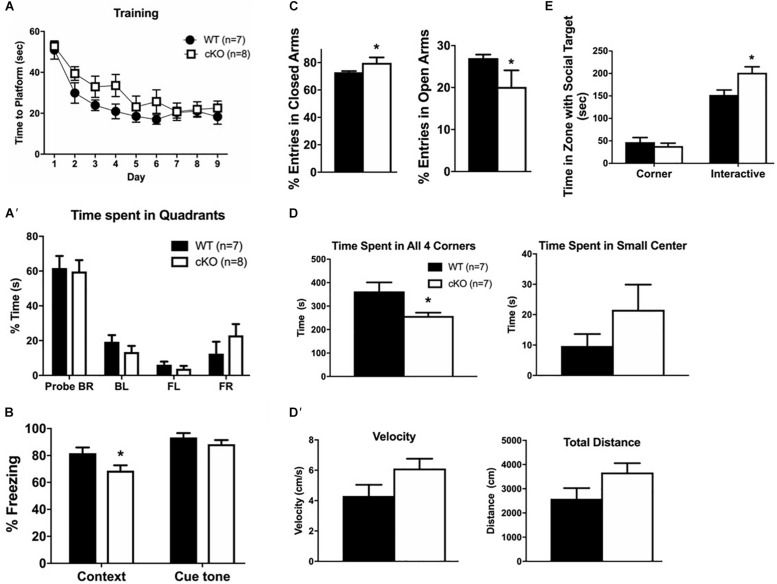
Cortical projection neuron dysgenesis alters cognitive function. (A) Morris water maze training sessions. The time it took the mice to reach the platform was recorded. No statistically significant differences were detected between genotypes during 9 days of training. (A’) Trial day 10 in the Morris water maze reveals no differences in the percentage of time spent in the different quadrants. Both WT and mutant mice spent most time in the BR quadrant that contained the platform. (B) The fear-conditioning assay reveals that mutant mice responded normally to the cue tone after training but have a reduced context-dependent response relative to controls. (C) The elevated plus maze reveals that mutant mice have a higher percentage of total entries into the closed arms, but a lower percentage of entries into the open arms relative to controls. (D) The open field test reveals that mutant mice spent more time in the brightly lit center and less time in any of the corners. However, this was not a function of speed or total distance traveled (D’) as they showed no difference to control animals. (E) The social interaction assay reveals that mutant mice spent more time interacting with a stranger mouse than with an inanimate object relative to controls. For all tests, n = 7–10 mice per genotype were used, values are presented as the mean ± SEM. ∗P < 0.05, one-way ANOVA, except for panels (A’,E), which utilized two-way ANOVA with multiple comparisons.